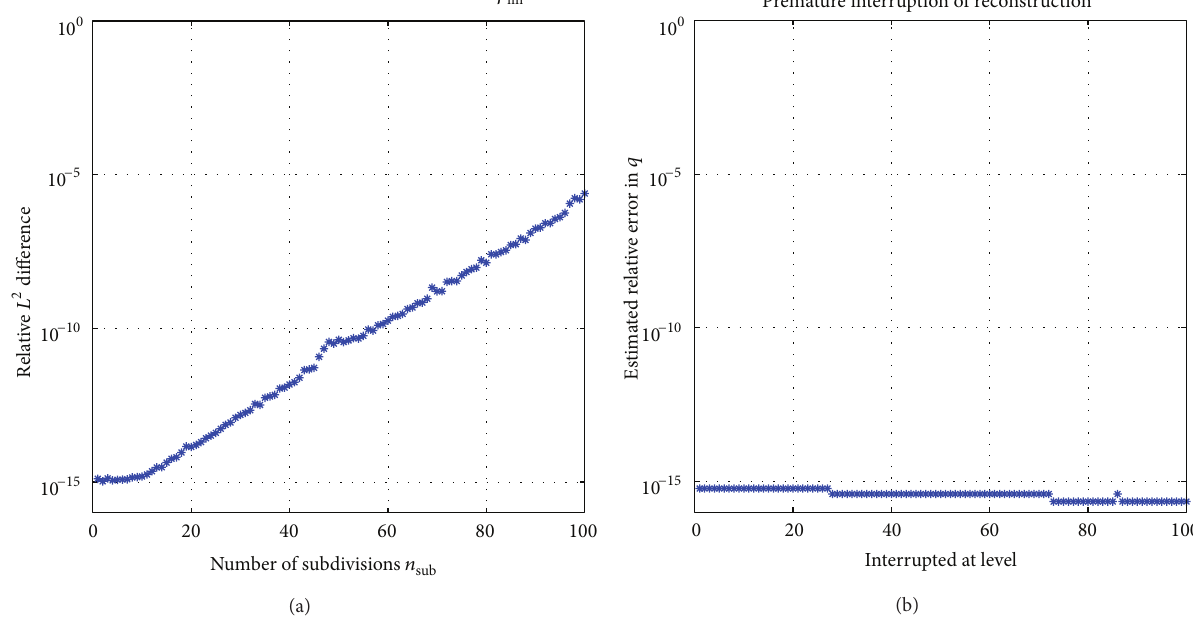
Figure 8: Output from demo4.m and demo5.m . (a) A comparison of 𝜌 (17) via (33). (b) Relative accuracy in 𝑞 of (6) from part-way reconstructed solutions ̂ 𝜌